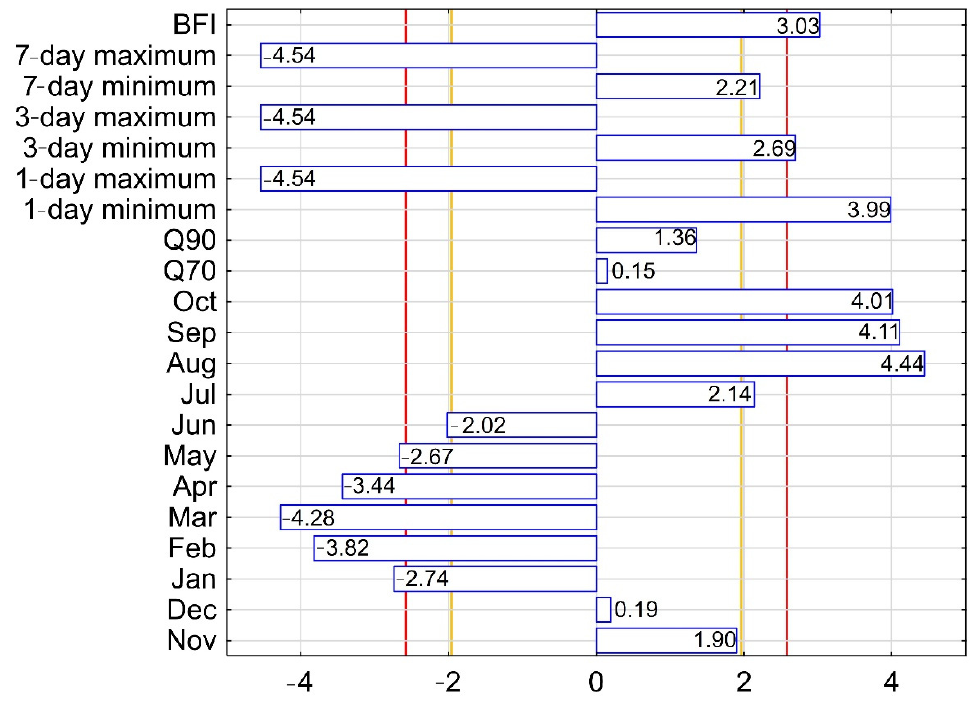
Figure 4. Changes in characteristics of flows resulting from the construction of the Jeziorsko dam reservoir.